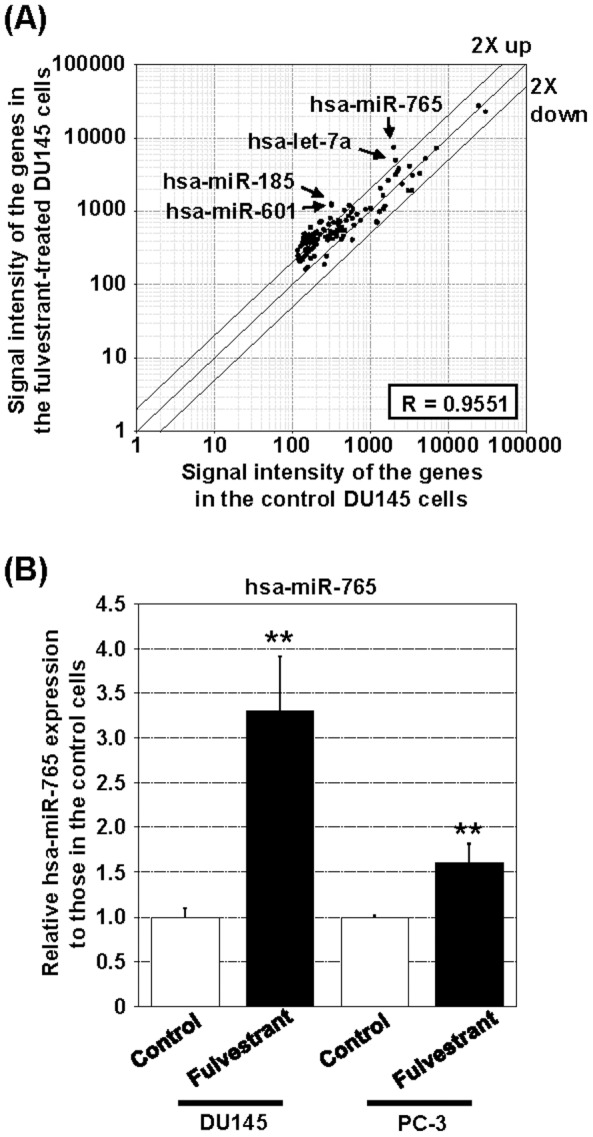
Fulvestrant upregulates hsa-miR-765 expression in DU145 cells.(A) Hsa-miR-765 is highly expressed in fulvestrant-treated DU145 cells. Total RNAs of treated cells were labeled directly and arrayed on the NCode Human miRNA Microarray. The median- and linear regression-normalized data are presented in a scatterplot. (B) Hsa-miR-765 is induced by fulvestrant in two prostate cancer cell lines. The hsa-miR-765 in the fulvestrant- and ethanol-treated control DU145 and PC-3 cells was quantified by miRNA qRT-PCR analysis. Relative fold changes between the expression of hsa-miR-765 in the fulvestrant-treated and control cells are presented. Student t-test was performed to determine their significance using a cutoff p value of 0.05 (n = 3). **p<0.01; bars = S.D.